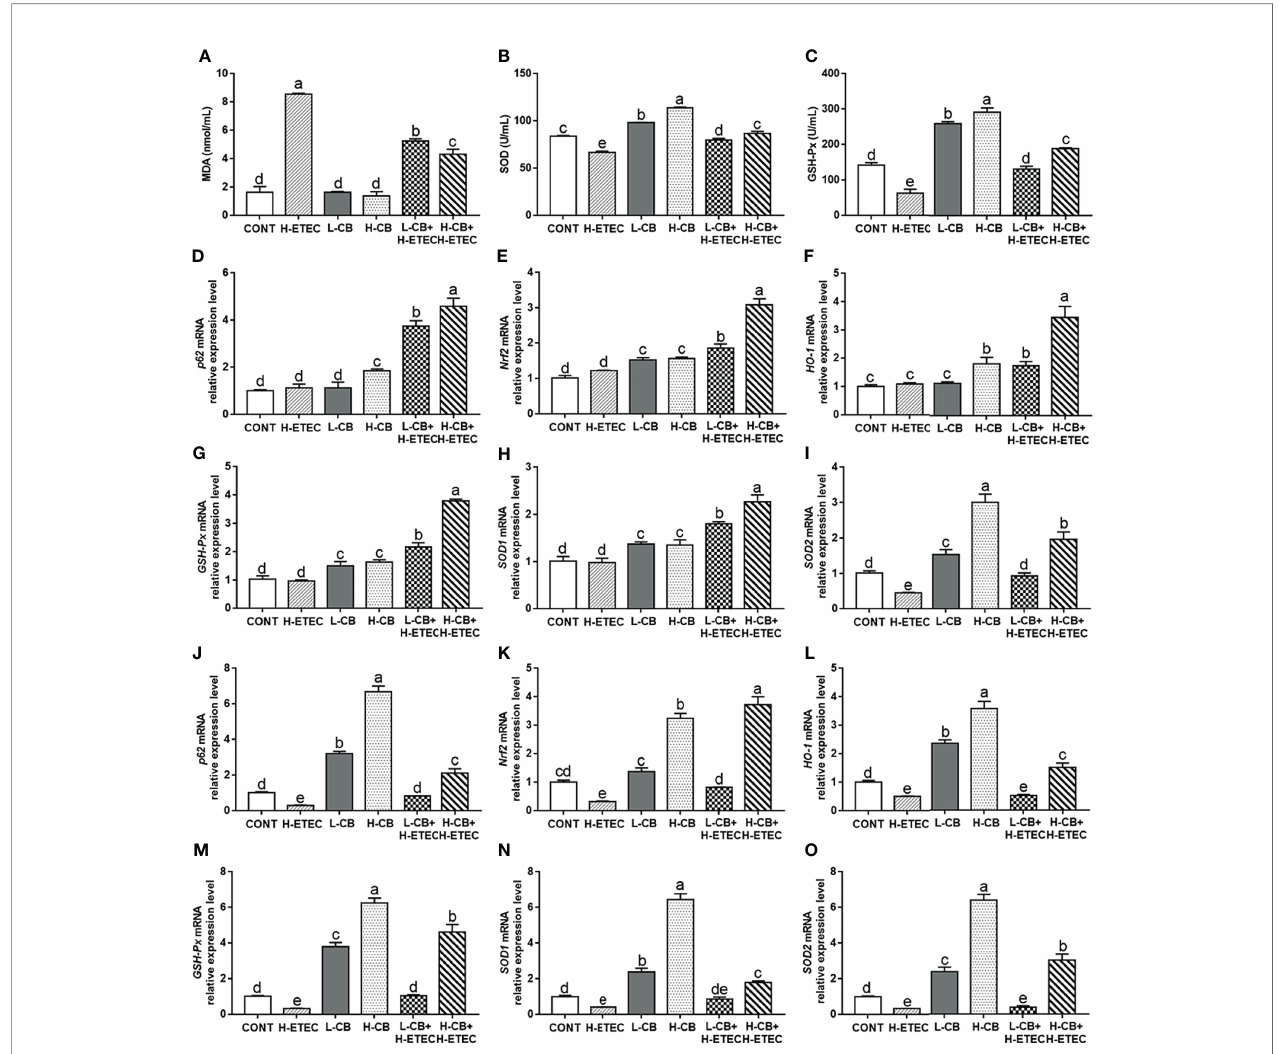
FIGURE 5 | Effects of CB and/or ETEC K88 on the levels of MDA, SOD, GSH-Px, p62 , Nrf2 , HO-1 , GSH-Px , SOD1 , and SOD2 in mice. (A – C) The levels of MDA, SOD, and GSH-Px in the serum of mice were measured (n = 6 mice per group). (D – I) The mRNA expression levels of p62 , Nrf2 , HO-1 , GSH-Px , SOD1 , and SOD2 in the livers of mice were measured by qRT-PCR (n = 6 mice per group). (J – O) The mRNA expression levels of p62 , Nrf2 , HO-1 , GSH-Px , SOD1 , and SOD2 in the livers of mice were measured by qRT-PCR (n = 6 mice per group). Data are shown as ratios of abundance of target gene transcripts in the treated mice to those in the control mice after normalization to GAPDH . Values shown are the means ± SEM. Different small letters indicate signi fi cant differences ( p <